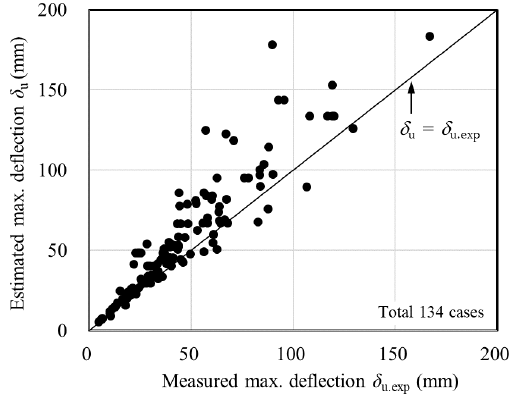
Figure 8. Comparison between the estimated and measured maximum deflections.